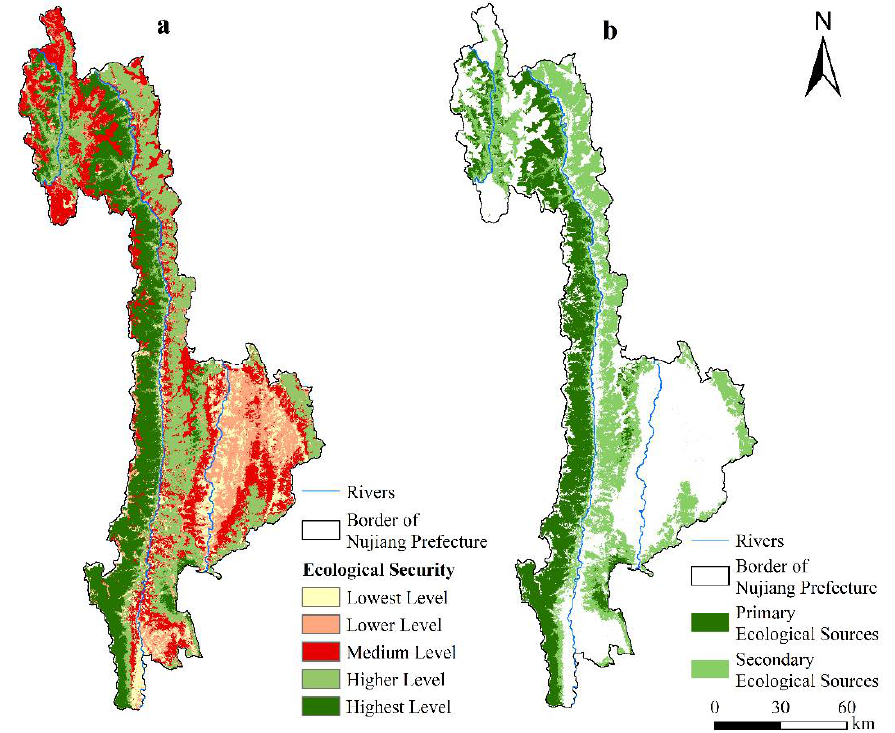
Figure 7. ( a ) Comprehensive evaluation of ecological security and ( b ) spatial distribution of ecological sources in Nujiang Prefecture.